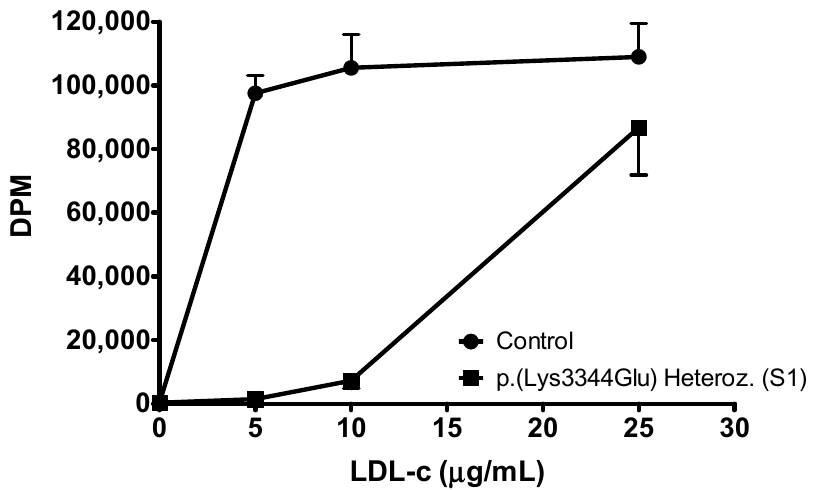
Figure 5. Ability of LDL from apoB p.(Lys3344Glu) heterozygous patient S1 to support U937 cell proliferation. [Methyl- 3 H]thymidine incorporation into DNA was measured in disintegrations per minute (DPM). Data represent the mean ± SEM of four replicates and are representative of two independent experiments with similar results ( p < 0.001). The identification of the p.(Lys3344Glu) carrier is indicated in brackets (see text).